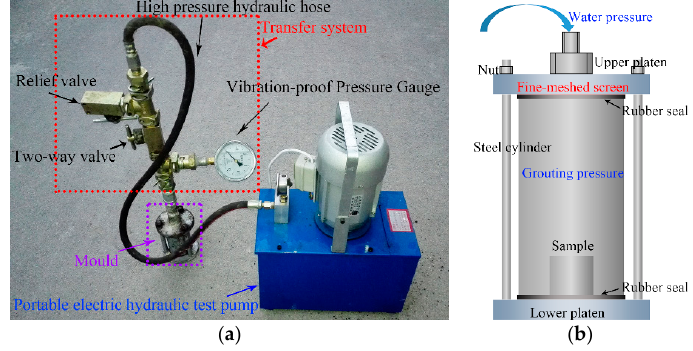
Figure 5. Laboratory-scale grouting system. ( a ) Grouting system; and ( b ) detail of mould assembly.